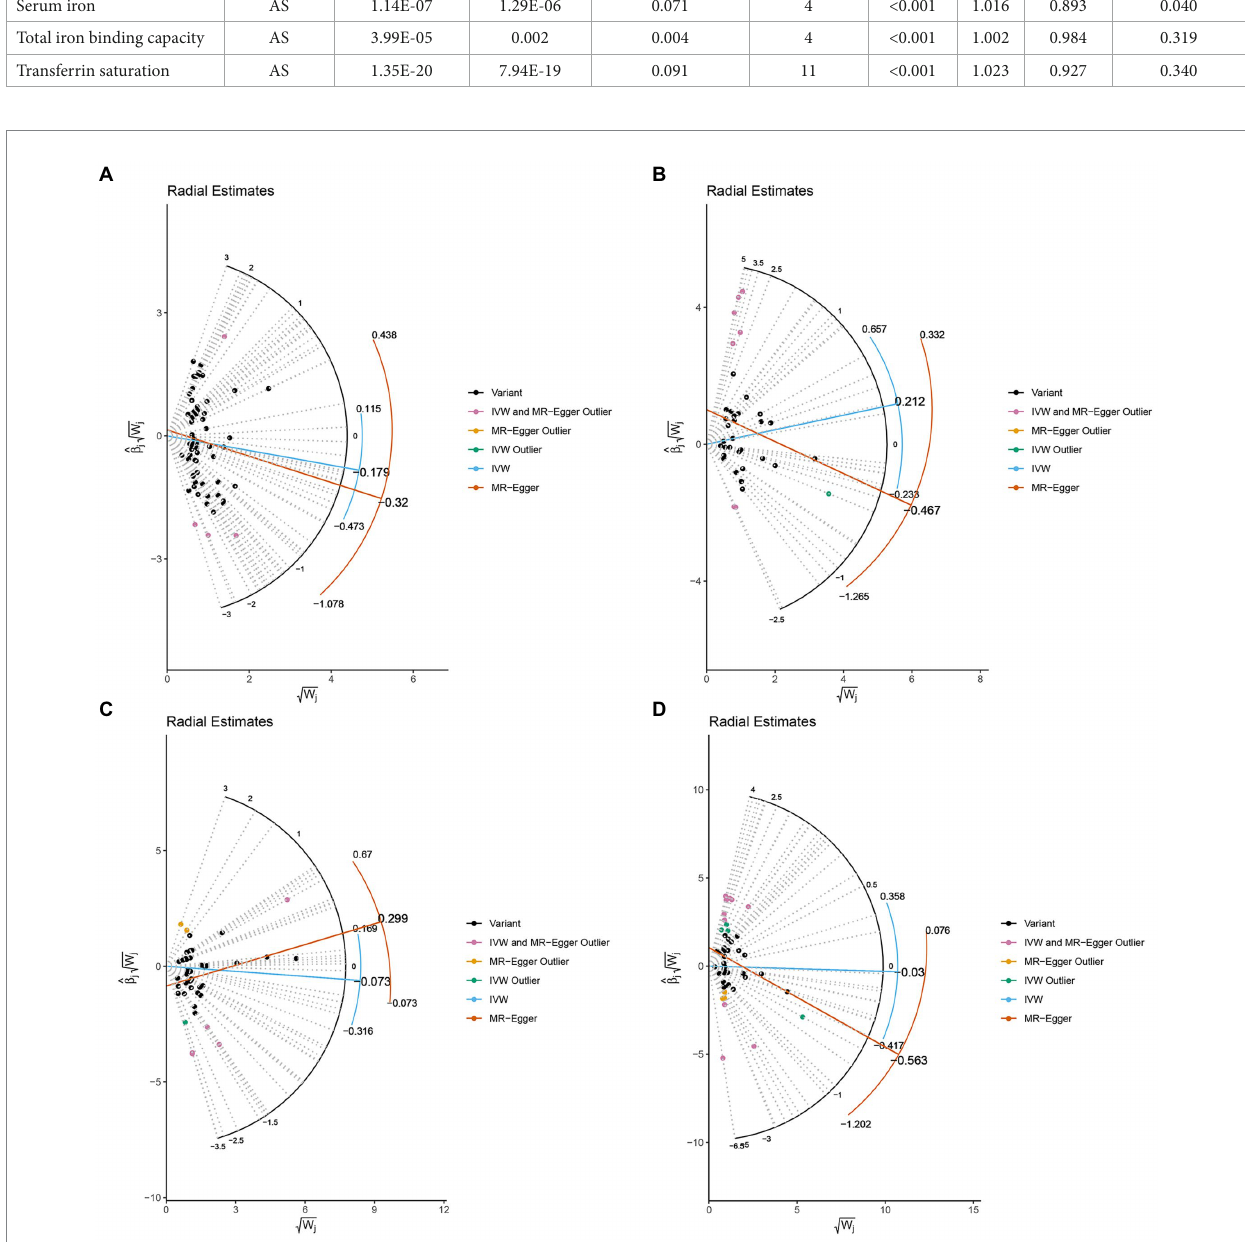
FIGURE 3 Radial plots to visualize individual outlier SNPs in the MR estimates. The radial curve displays the ratio estimate for each SNP. Black dots show valid SNPs. (A) MR radial plots of ferritin and ankylosing spondylitis. (B) MR radial plots of serum iron and ankylosing spondylitis. (C) MR radial plots of total iron binding capacity and ankylosing spondylitis. (D) MR radial plots of transferrin saturation and ankylosing spondylitis.